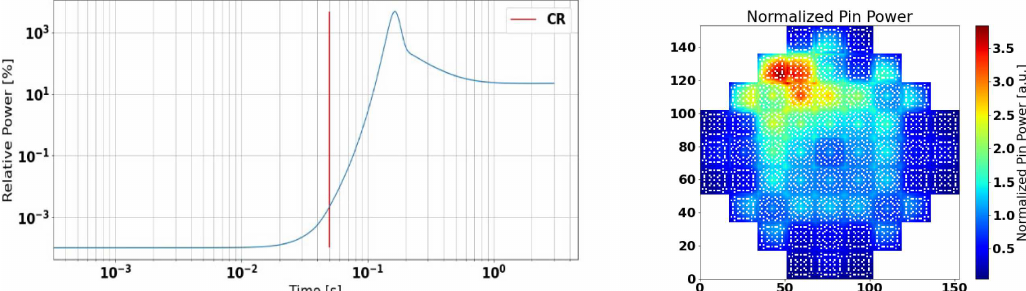
Fig. 7. PARCS/Subchanflow Relative power evolution (left) and radial power distribution (right) in the SMART-core during a REA.